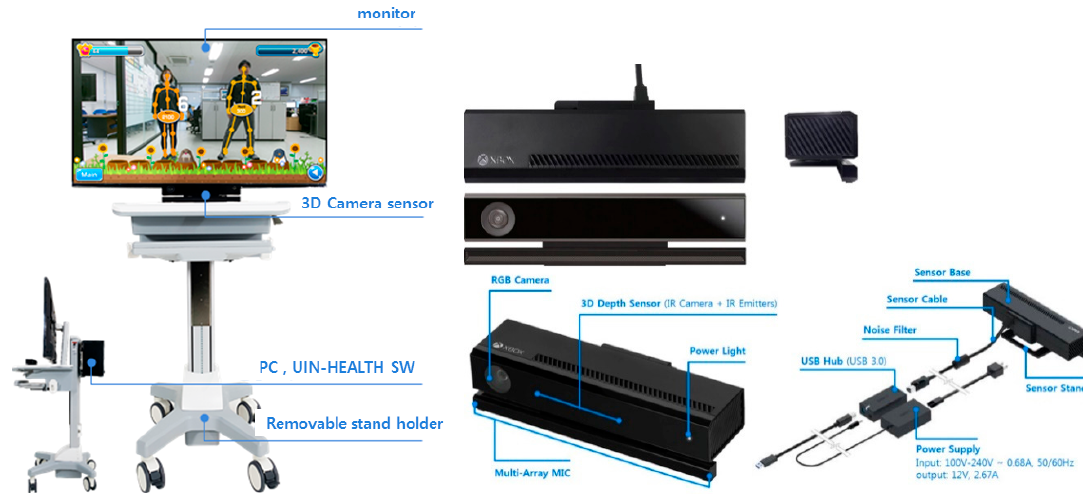
Figure 2. Augmented-reality-based exercise rehabilitation system, UIN-HEALTH TM .214.